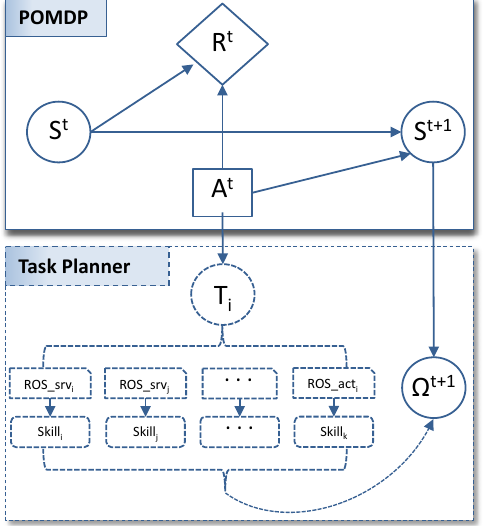
Figure 13. The POMDP and task planner integration schema. At the top, the causal relationships between POMDP states, actions, rewards, and observations are illustrated in accordance with [42] policy graph interpretation. At the bottom, the task planner functionality is illustrated, where each action is assigned to a specific task, which is further decomposed into ROS functionalities, i.e., action, service, node, which implements a specific robot Skill i . The outcome of each skill execution is coded and returned as observation ω i to the policy graph of the